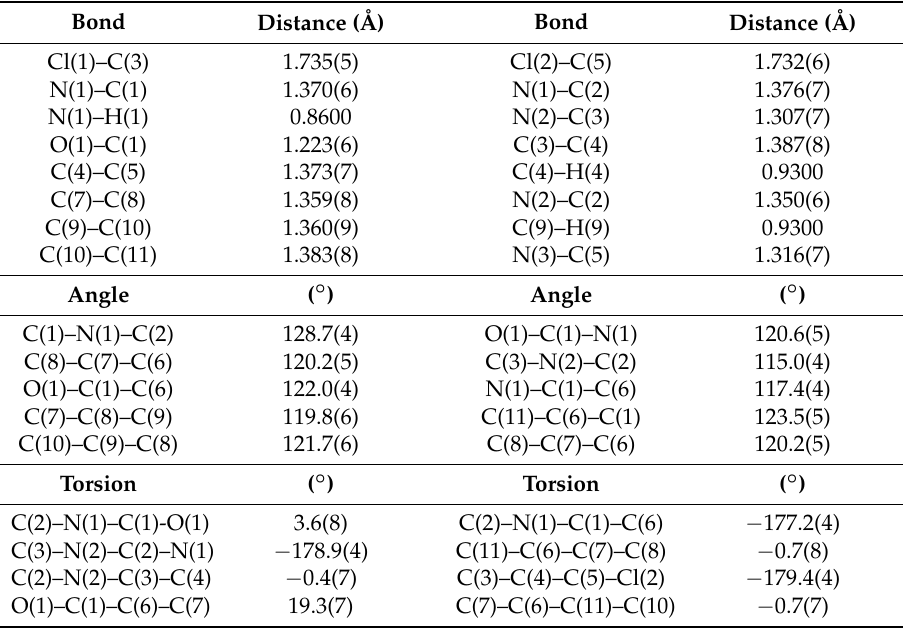
Table 2. Selected molecular structure